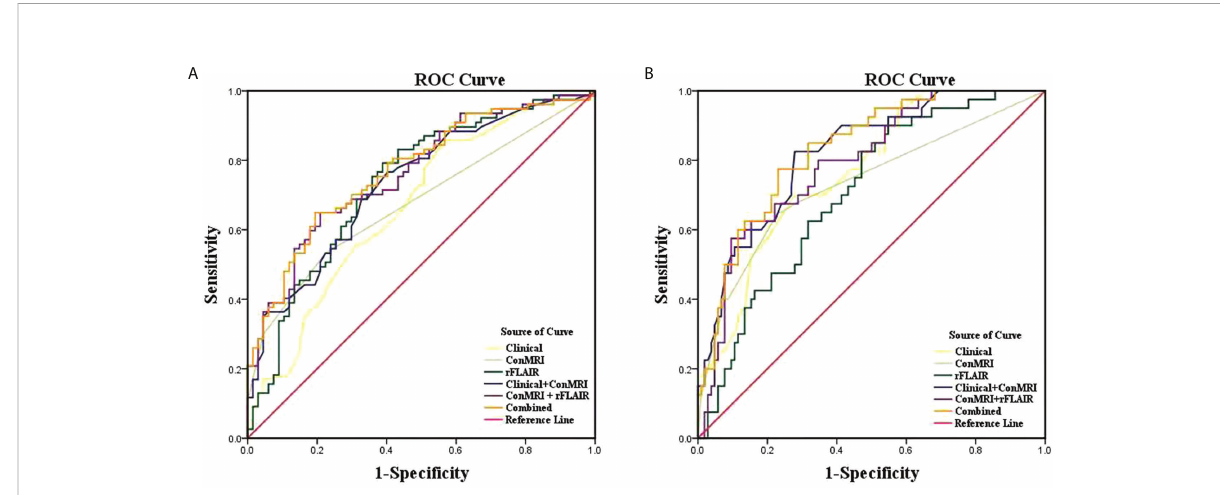
FIGURE 4 Receiver operating characteristic (ROC) analysis of different factors in the survival assessment of LGG patients. (A) ROC for PFS. (B) ROC for OS. Clinical: including age, radiation dose, KPS, Ki-67, and WHO grades; Combined: including clinical, Con MRI fi ndings, and rFLAIR; Con MRI: including new remote enhancement, the enhancement pattern of the residual cavity wall, and SVZ; LGG: lower-grade glioma; OS: overall survival; PFS: progression-free survival; rFLAIR: relative FLAIR; ROC: receiver operating characteristic curve.